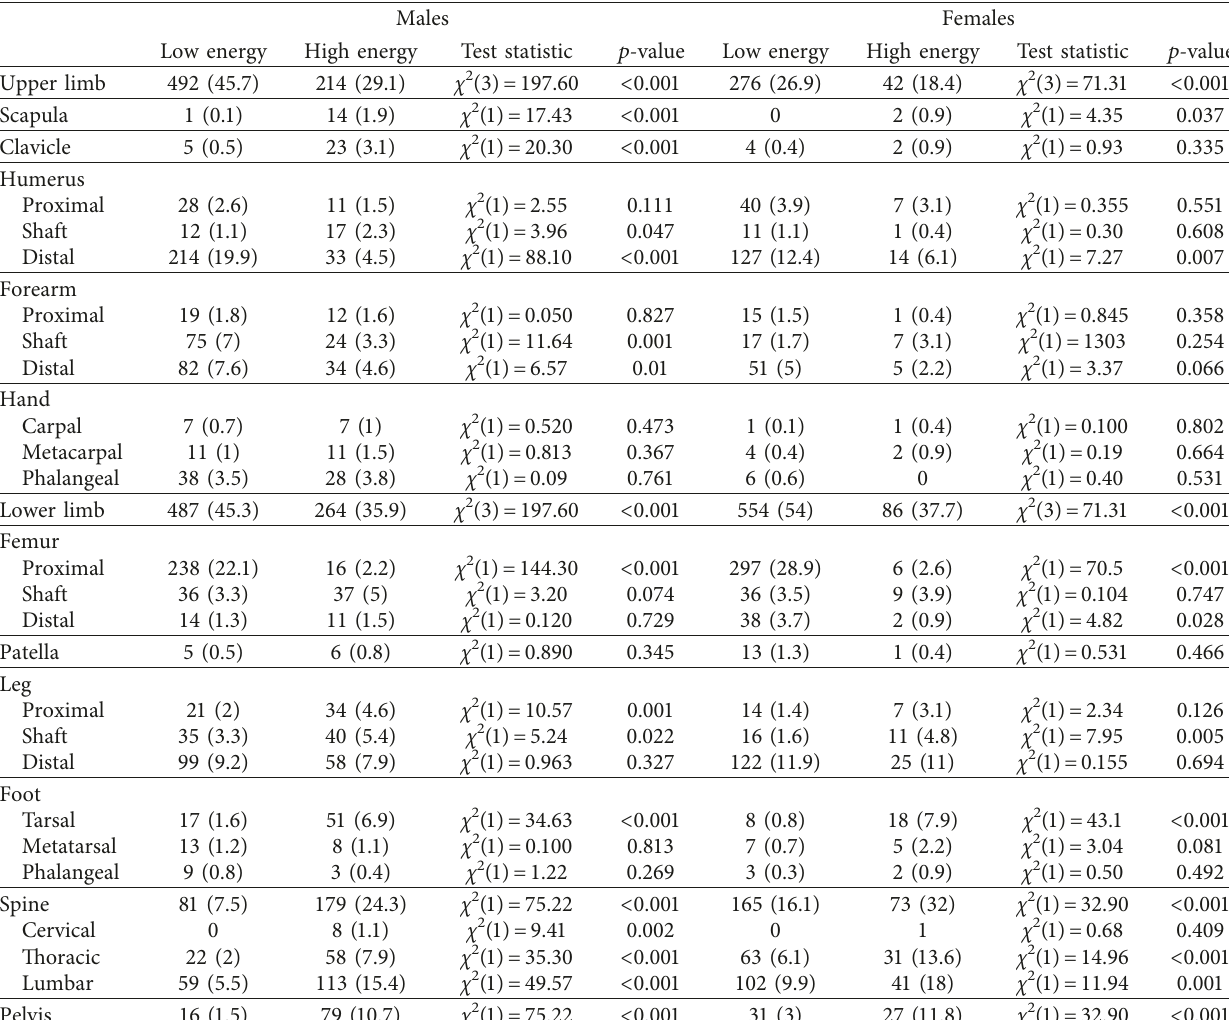
Table 7: Bivariate analysis between both genders’ bone fractures in low- and high-energy injuries, n � 3066.